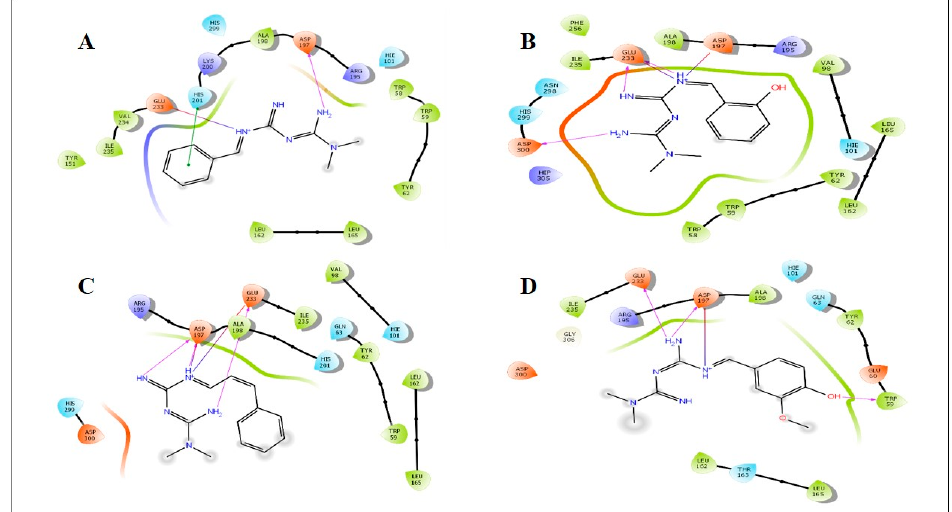
Figure 4. Induced fit docking study of the best pose generated on α -amylase (5E0F): ( A ) Met1 ligand-binding site; ( B ) Met2 ligand-binding site; ( C ) Met3 ligand-binding site; ( D ) Met8 ligand-binding site.